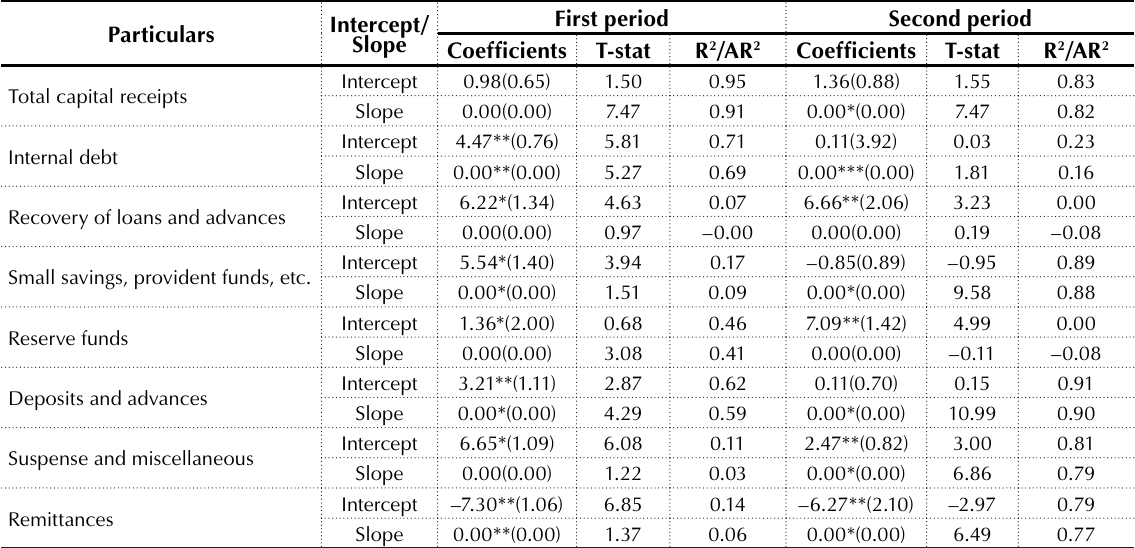
Table 7. Regression results for capital receipts of the state government Intercept/ Particulars